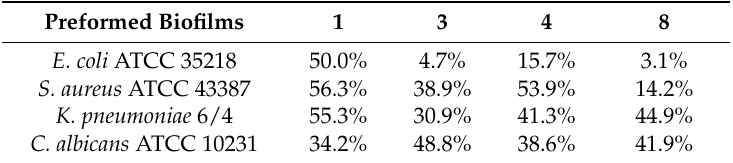
Table 3. Percentages of biofilm eradication activity assessed for E. coli ATCC 35218, S. aureus ATCC 43387, K. pneumoniae 6/4 and C. albicans ATCC 10231 after 30 min of contact with compounds 1 , 3 , 4 , and 8 at their relative MIC ( µ g/mL) values. Percentages were determined after spectrophotometer reader (OD 570nm